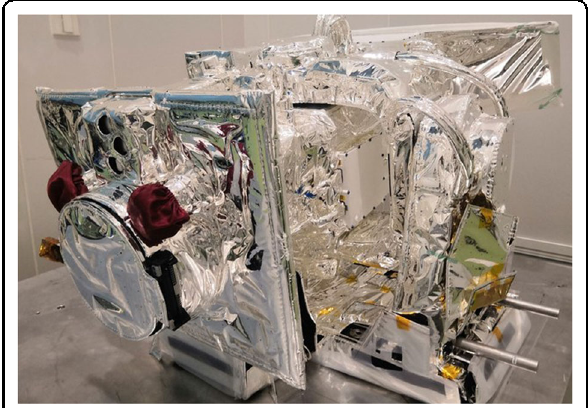
Fig. 2 The X-EUVI loaded onto the Fengyun-3E